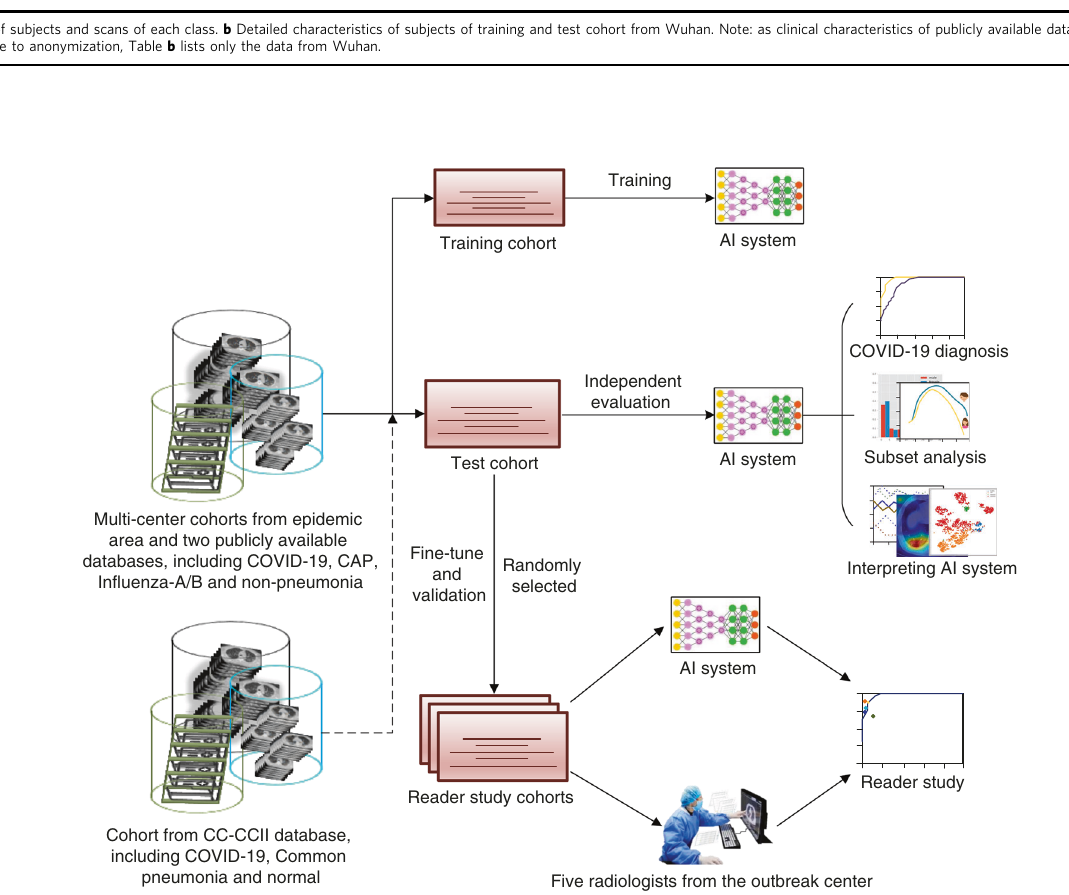
Fig. 1 Work fl ows of the whole study and AI system. a Work fl ow of the whole study. b Construction and usage of the AI